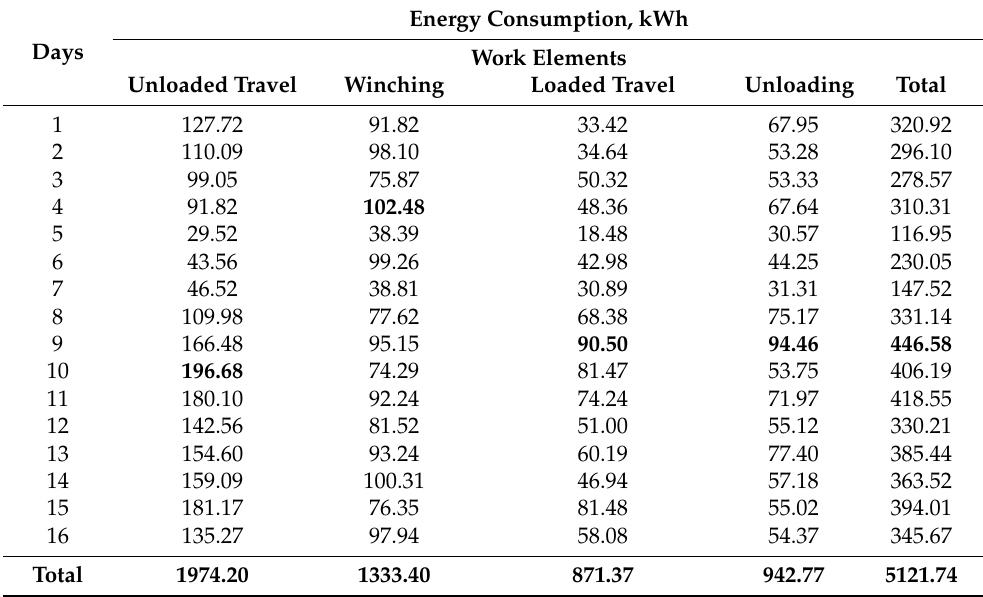
Table 4. Total energy consumption of skidder per work element.